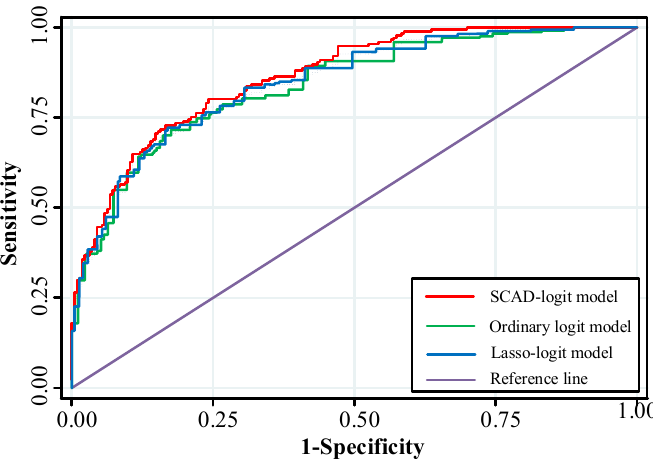
Figure 8. ROC curves.